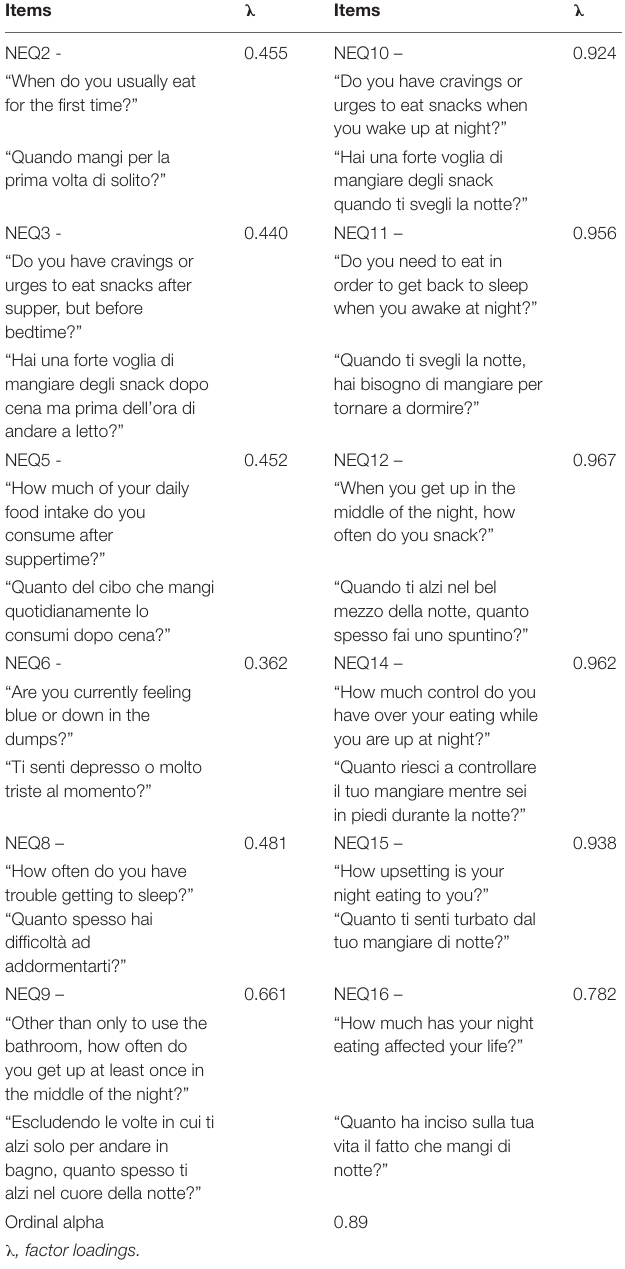
TABLE 2 | Standardized factor loadings for the I-NEQ-16 ( n = 482).